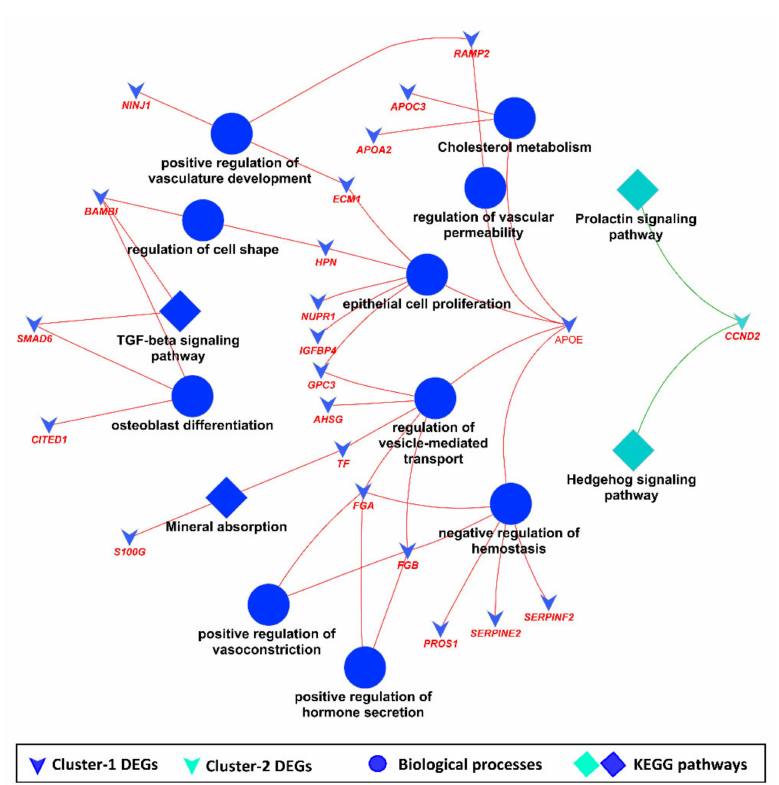
Figure 7. KEGG pathway and GO enrichment analysis of common DEG